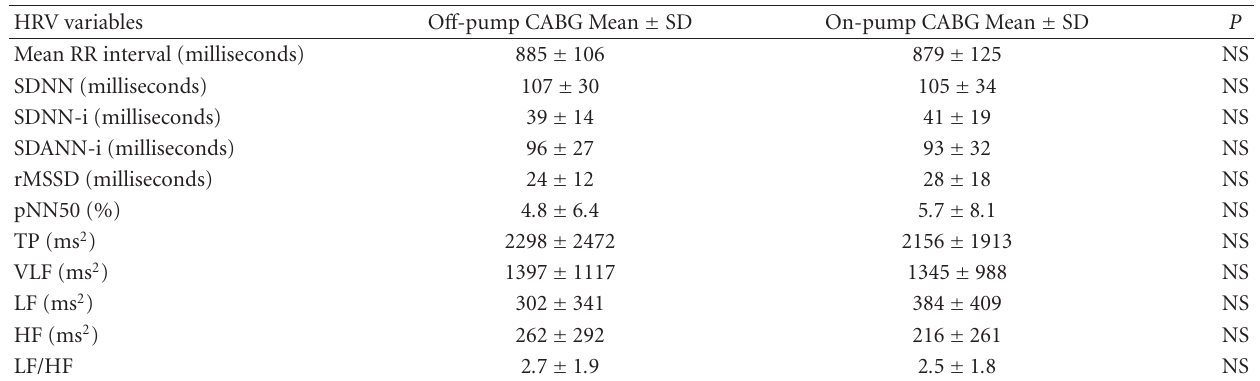
Table 2: Di ff erences in heart rate variability between o ff -pump versus on-pump CABG patients. HRV